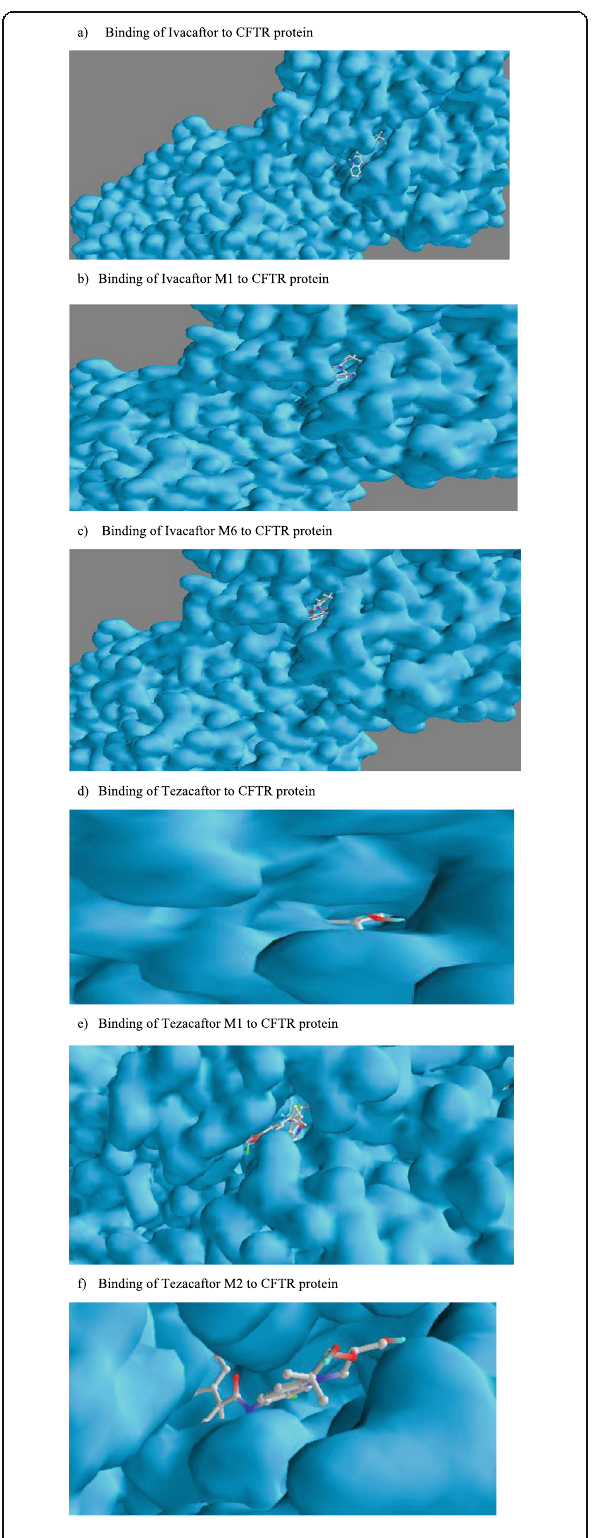
Fig. 8 In silico docking studies by PyRx tool. a Binding of Ivacaftor to CFTR protein. b Binding of Ivacaftor M1 to CFTR protein. c Binding of Ivacaftor M6 to CFTR protein. d Binding of Tezacaftor to CFTR protein. e Binding of Tezacaftor M1 to CFTR protein. f Binding of Tezacaftor M2 to CFTR